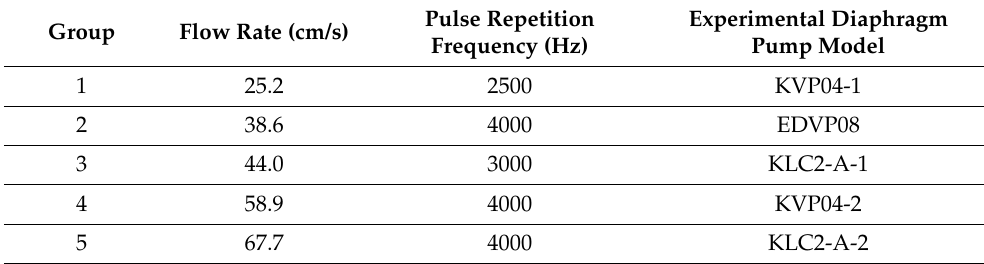
Table 1. Parameters of blood flow phantom experiment setup at different flow rates.